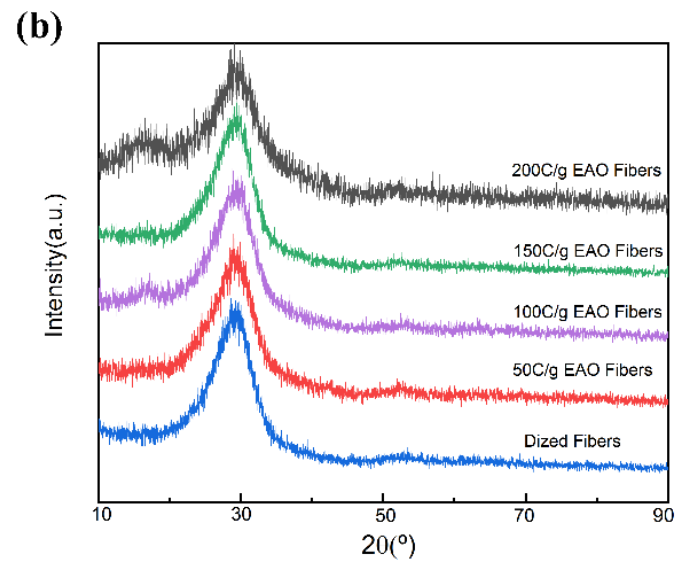
Figure 6. ( a ) Single-filament tensile strength (The dotted line in the figure indicates we set 4 GPa as the reference.) and ( b ) XRD curve of desized CFs and CFs treated with different EAO intensities. It can be seen from the XPS test that the EAO treatment added functional groups containing O and N elements to the surface of CFs. These active functional groups con- tributed to the loading of catalyst precursor particles. These changes are reflected in the structure of the surface graphite crystallites. Figure 6b demonstrates the XRD patterns of the desized CFs and CFs with different electrochemical treatment intensities. It can be seen that each sample had a wide diffraction peak around 2 θ = 25.6 ◦ , which is the characteristic diffraction peak of the (002) crystal plane of the CF surface through data comparison; the more complete the graphite turbostratic structure, the sharper the peak shape. Compared with the desized CFs, the peak shapes of the treated samples were broadened, indicating that the graphite structure was damaged to different degrees.